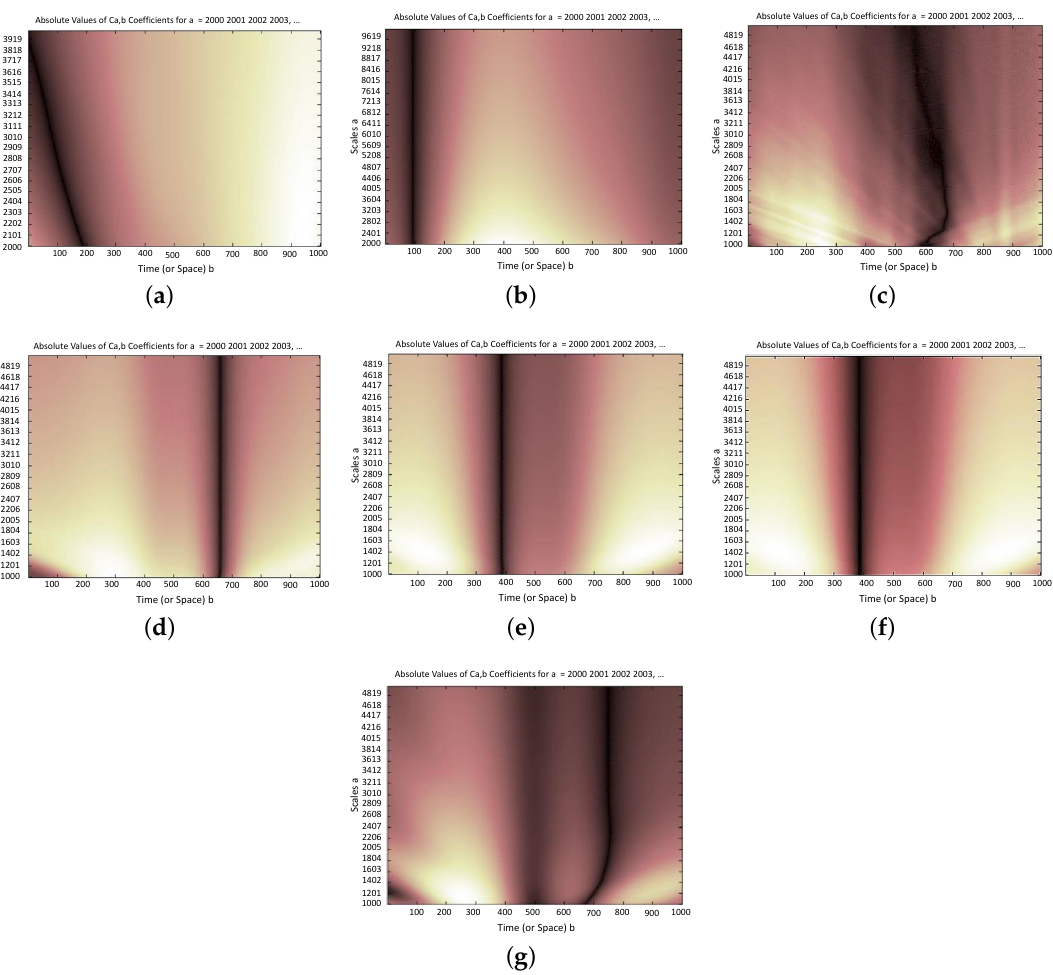
Figure 15. Summation of the wavelet coefficients for different scenarios. ( a ) Scenario #1; 1st